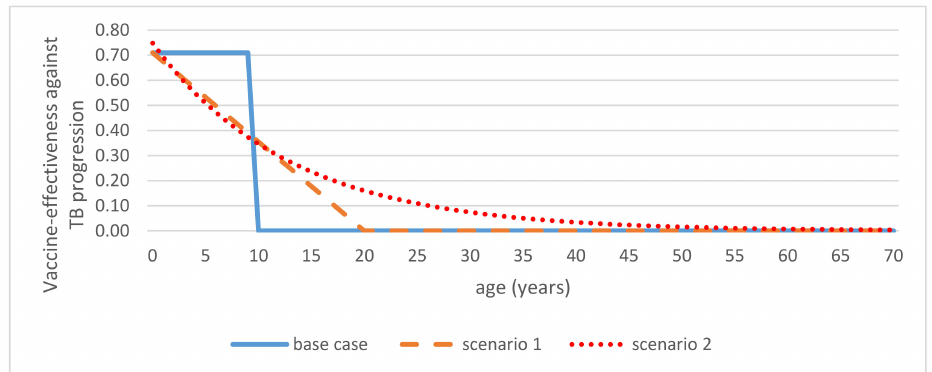
Figure 2. Waning e ff ect scenarios for the e ff ectiveness of the Bacillus Calmette–Guerin (BCG) vaccine against tuberculosis (TB) progression. Three di ff erent periods of waning protections were considered: A 10 year-only protection (base case), a linear waning e ff ect over 20 years (scenario 1), and an exponential waning e ff ect (scenario 2). The same waning scenarios were applied to other values of vaccine e ffi cacy